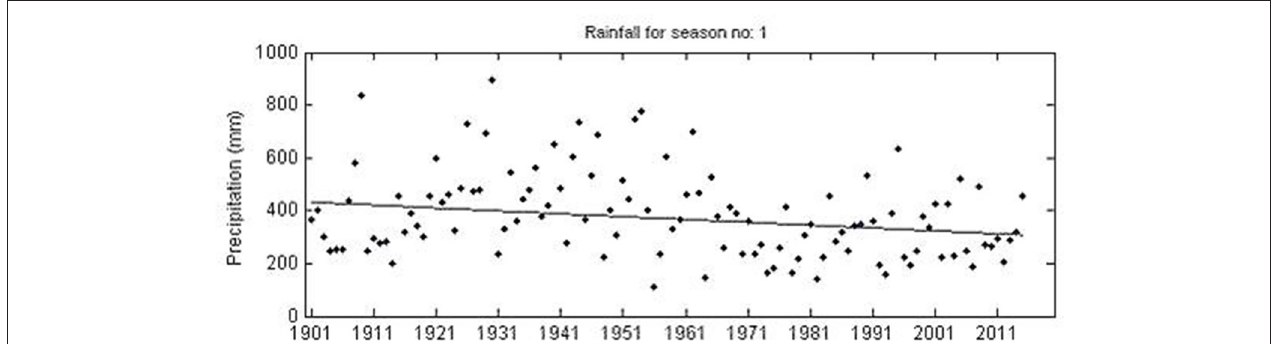
FIGURE 3 | Centennial trend of summer month’s (January to May) precipitation for Pampadumpara.